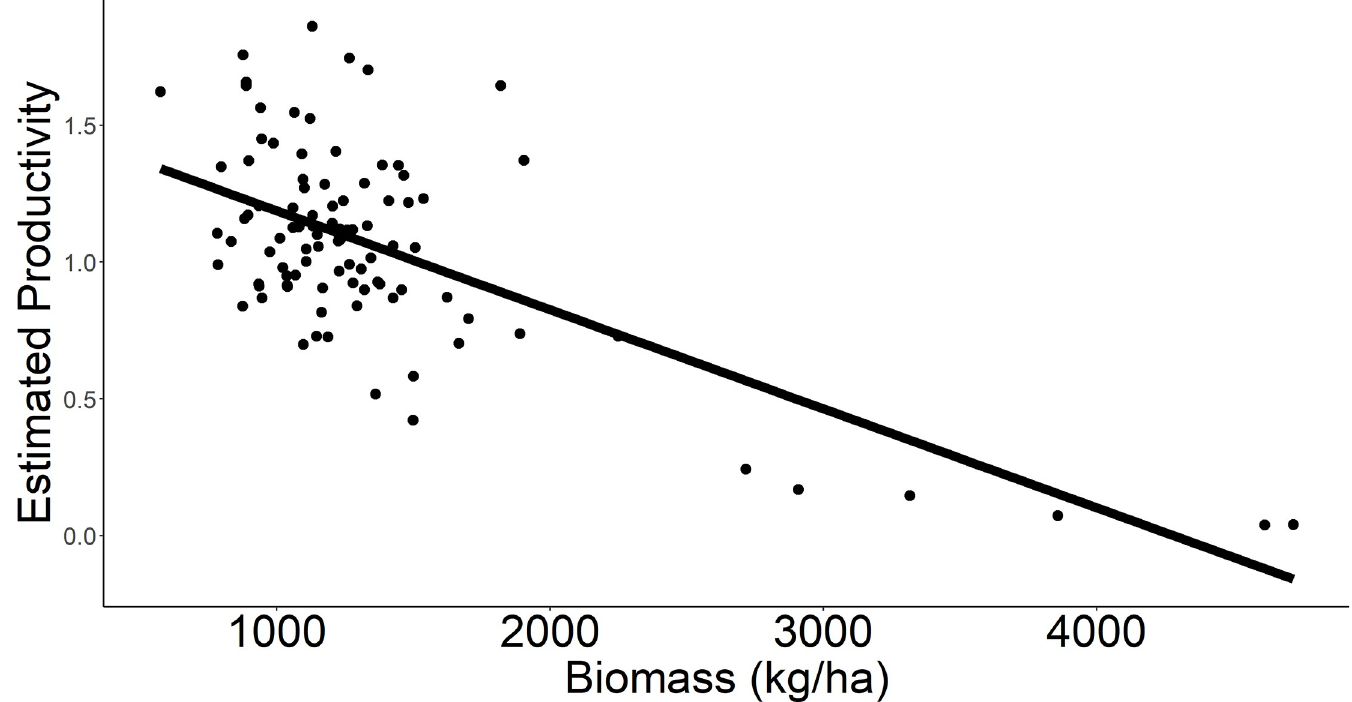
Fig 5. Estimated productivity of chestnut-collared longspurs by plot-scale biomass. Estimated mean productivity (successful nests per 9 ha plot) in relation to average plot-scale herbaceous biomass in Phillips County, MT during May–July of 2017 and 2018.